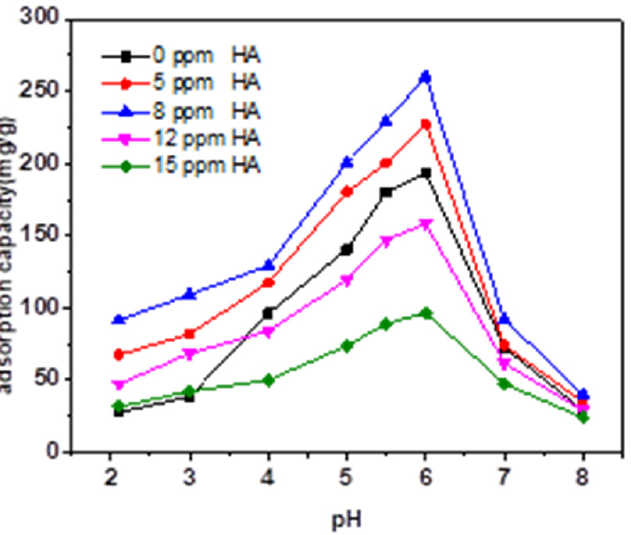
Figure 5. Effect of HA in different concentrations on TC adsorption by magnetic sludge biochar (adsorption time: 18 h).